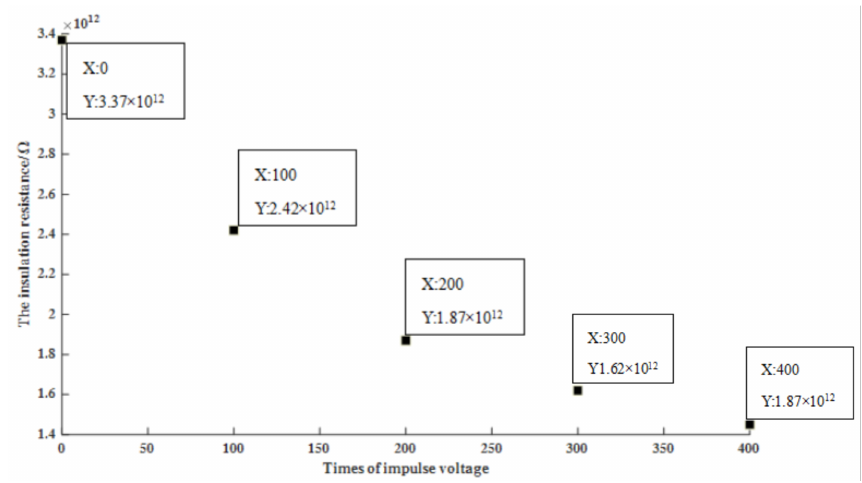
Figure 11. Variation trend of insulation resistance of oil-film dielectric with different numbers of impulse voltages.